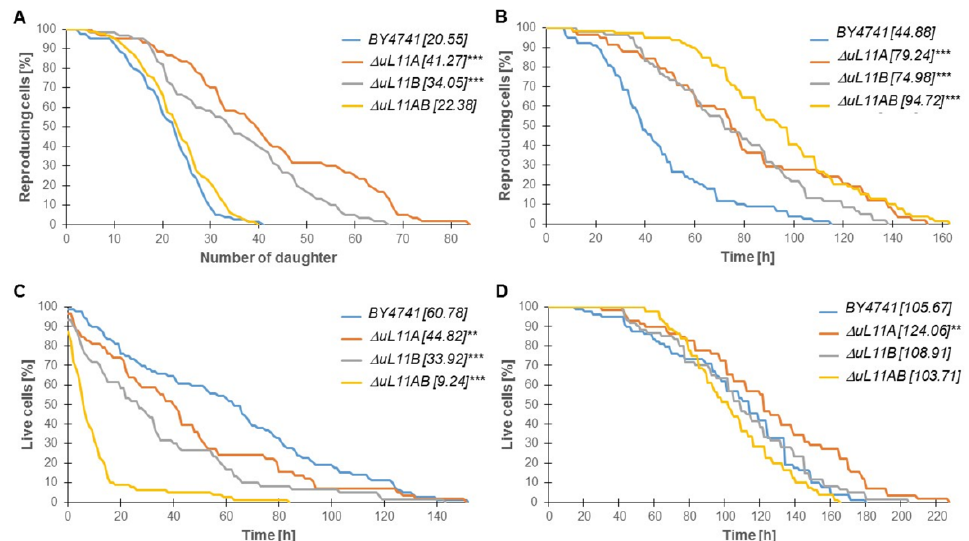
Figure 5. Aging analysis of uL11 yeast mutants. Comparison of the budding lifespan ( A ), reproductive lifespan ( B ), post-reproductive lifespan ( C ), and total lifespan ( D ) of the haploid wild type yeast strain BY4741, isogenic single mutants ∆ uL11A , ∆ uL11B , and double mutant ∆ uL11AB after cultivation on solid YPD media. Statistical significances were assessed using ANOVA and Dunnett’s post hoc test (** p < 0.05, *** p < 0.001). Data represent mean values from two independent experiments. The mean values for 90 total cells from two independent experiments are shown in parentheses.